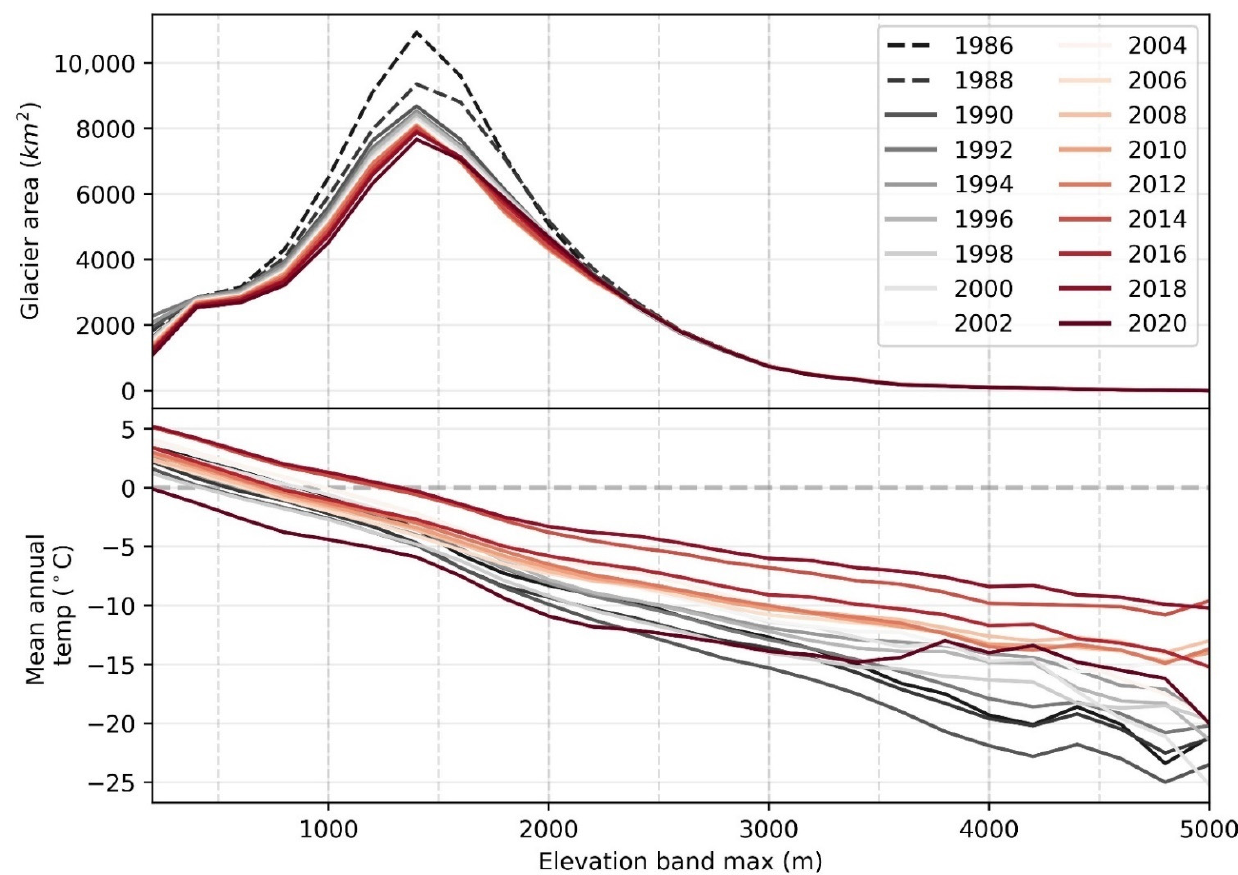
Figure 5. Summary of changes in glacier-covered area ( top ) and mean annual temperature ( bottom ) by biannual composite (line colors). Elevation is grouped into 200 m elevation bands. Supporting values for this figure can be found in Appendix A.3.